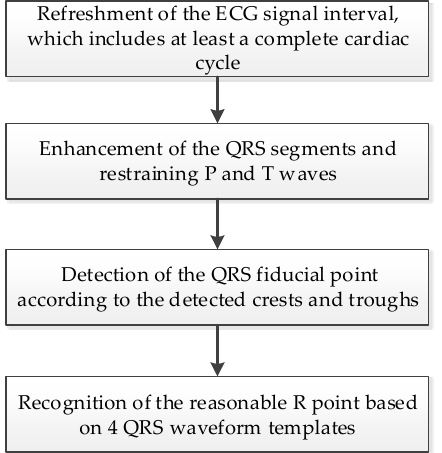
Figure 3. The procedures of the proposed real-time QRS detection and R point recognition method.